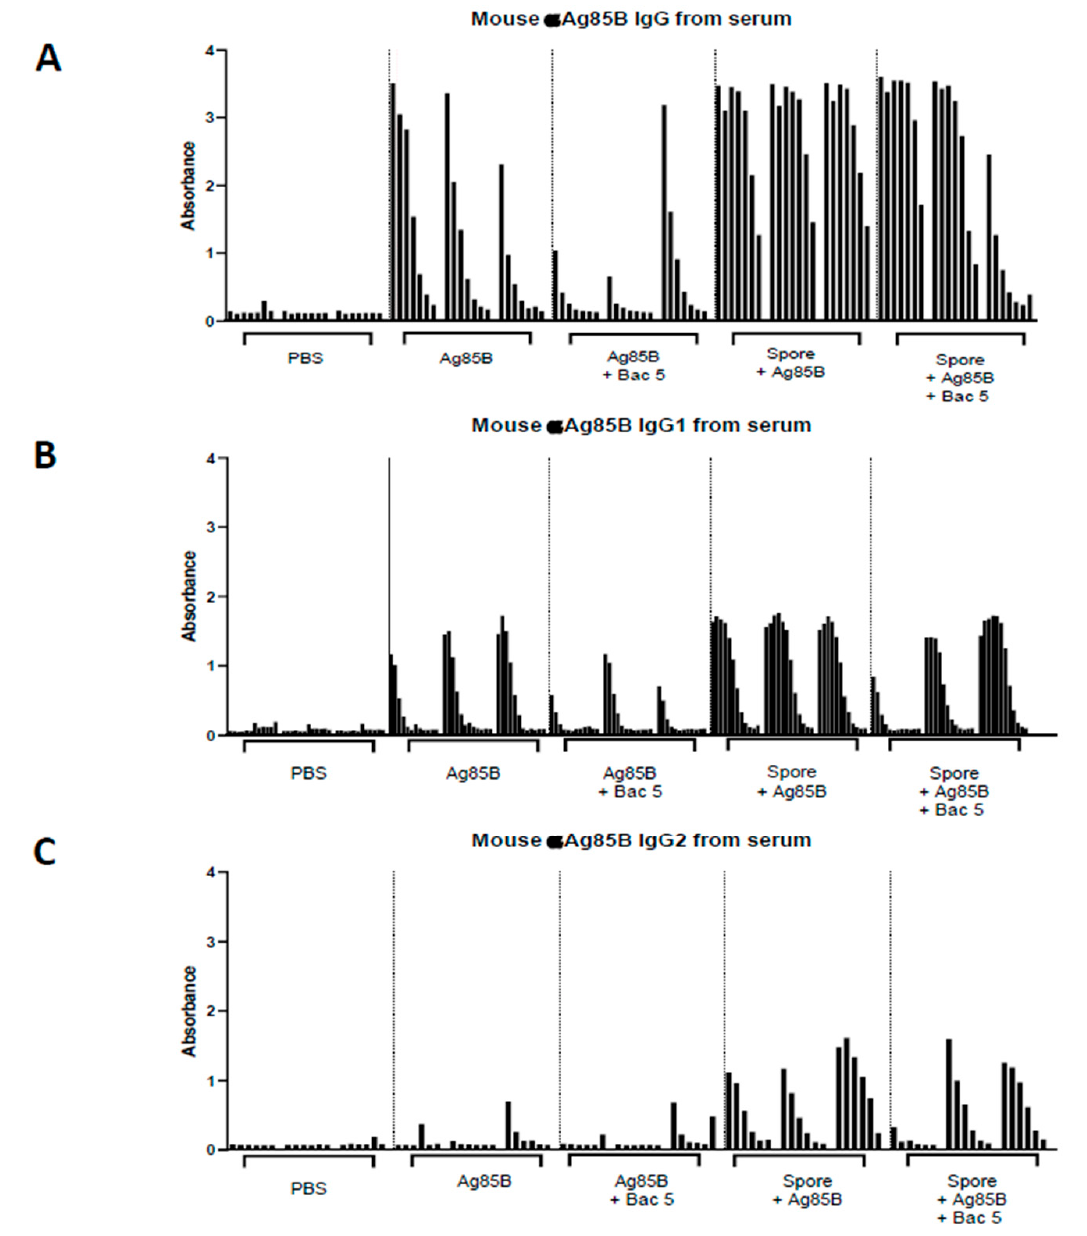
Figure 6. Adjuvant Effect of B. subtilis spores on IgG Titres in Response to Ag85 Vaccination. Eight to ten-week old female C57BL/6 mice were immunised with either PBS, Ag85B, or Ag85B plus B. subtilis spores, Bac5 peptide, or both combined ( x -axis). All units (n = 3 per group) received two doses, three weeks apart and three weeks after the final dose. Serum was recovered for measurement of α Ag85B-specific total IgG antibody ( A ), IgG1 ( B ) and IgG2 ( C ) subclass titres using ELISA. Sera from each biological replicate was diluted in a titration series and is displayed for each immunisation condition.